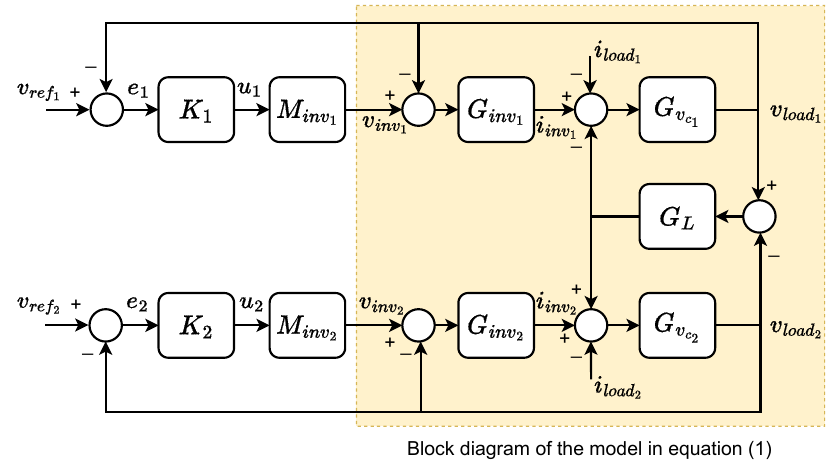
Figure 3. Closed-loop block diagram of the interconnected inverters with LC filters and interconnec- tion line dynamics. The open-loop dynamic equations in (1) are highlighted by a yellow